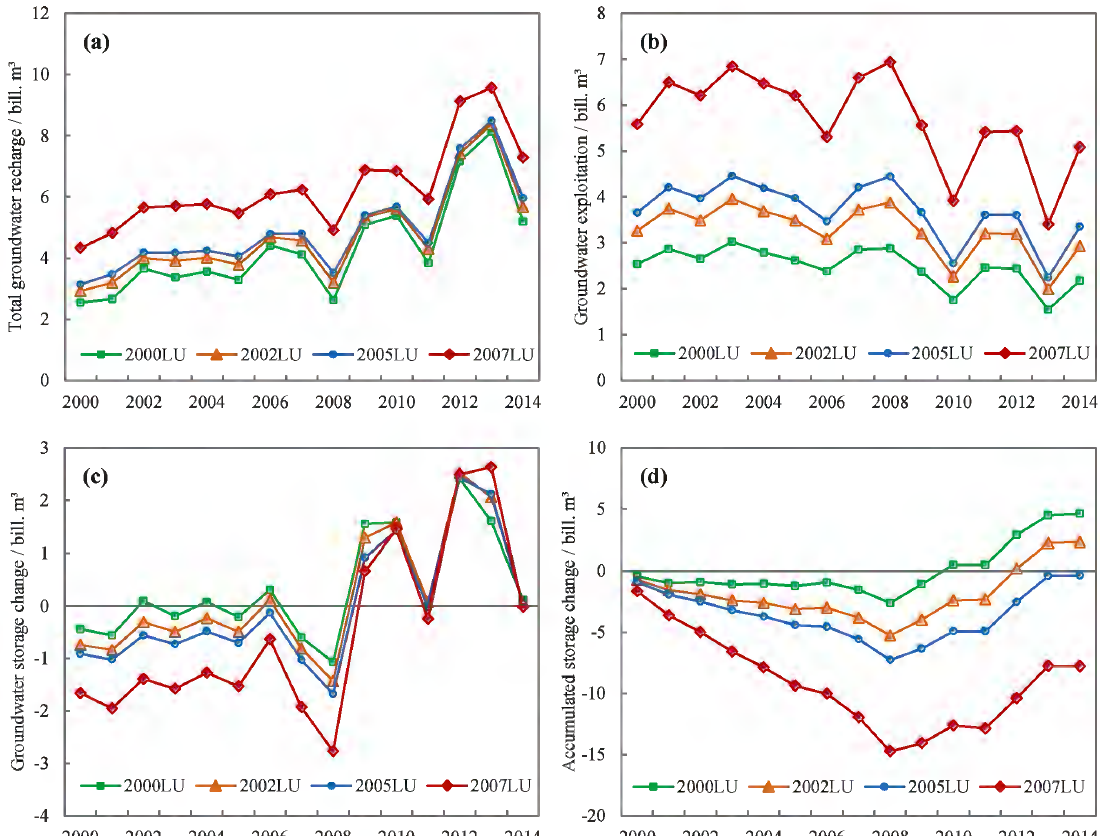
Figure 6. Comparison of main groundwater fluctuations and storage under LU in 2000, 2003, 2005, and 2007. ( a ) Total groundwater recharge, ( b ) groundwater exploitation, ( c ) groundwater storage change, and ( d ) accumulated storage